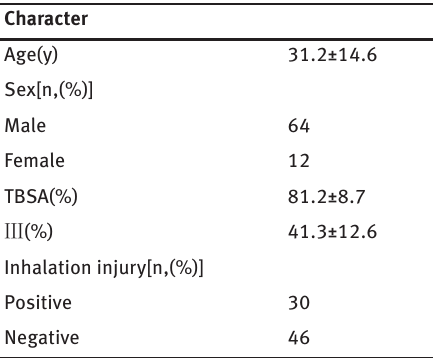
Table 1: Main character of the included 68